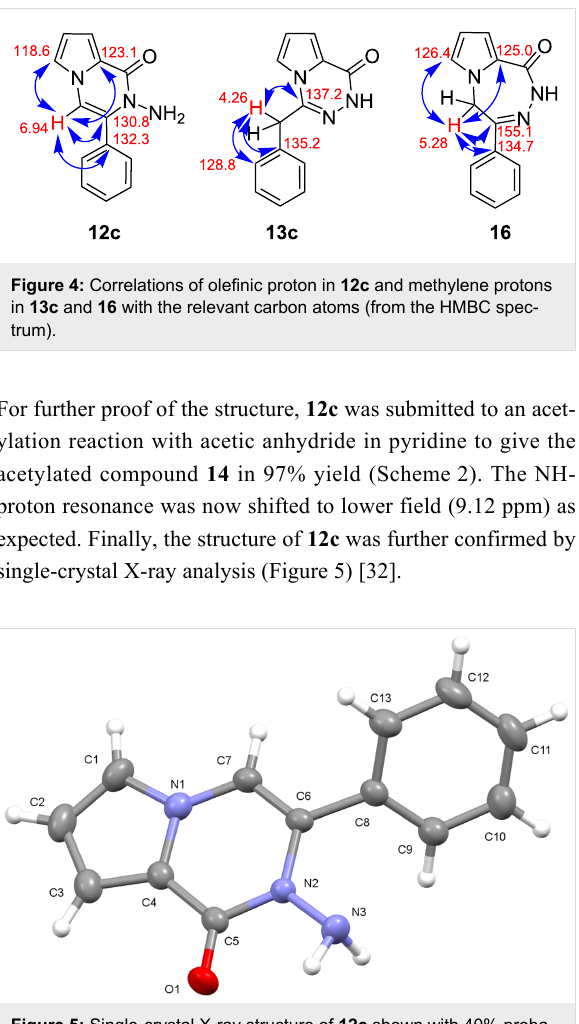
atoms resonating at 137.2 and 135.2 as well as with the aromat- ic o -carbon atoms at 128.8 ppm indicating the structure 13c .